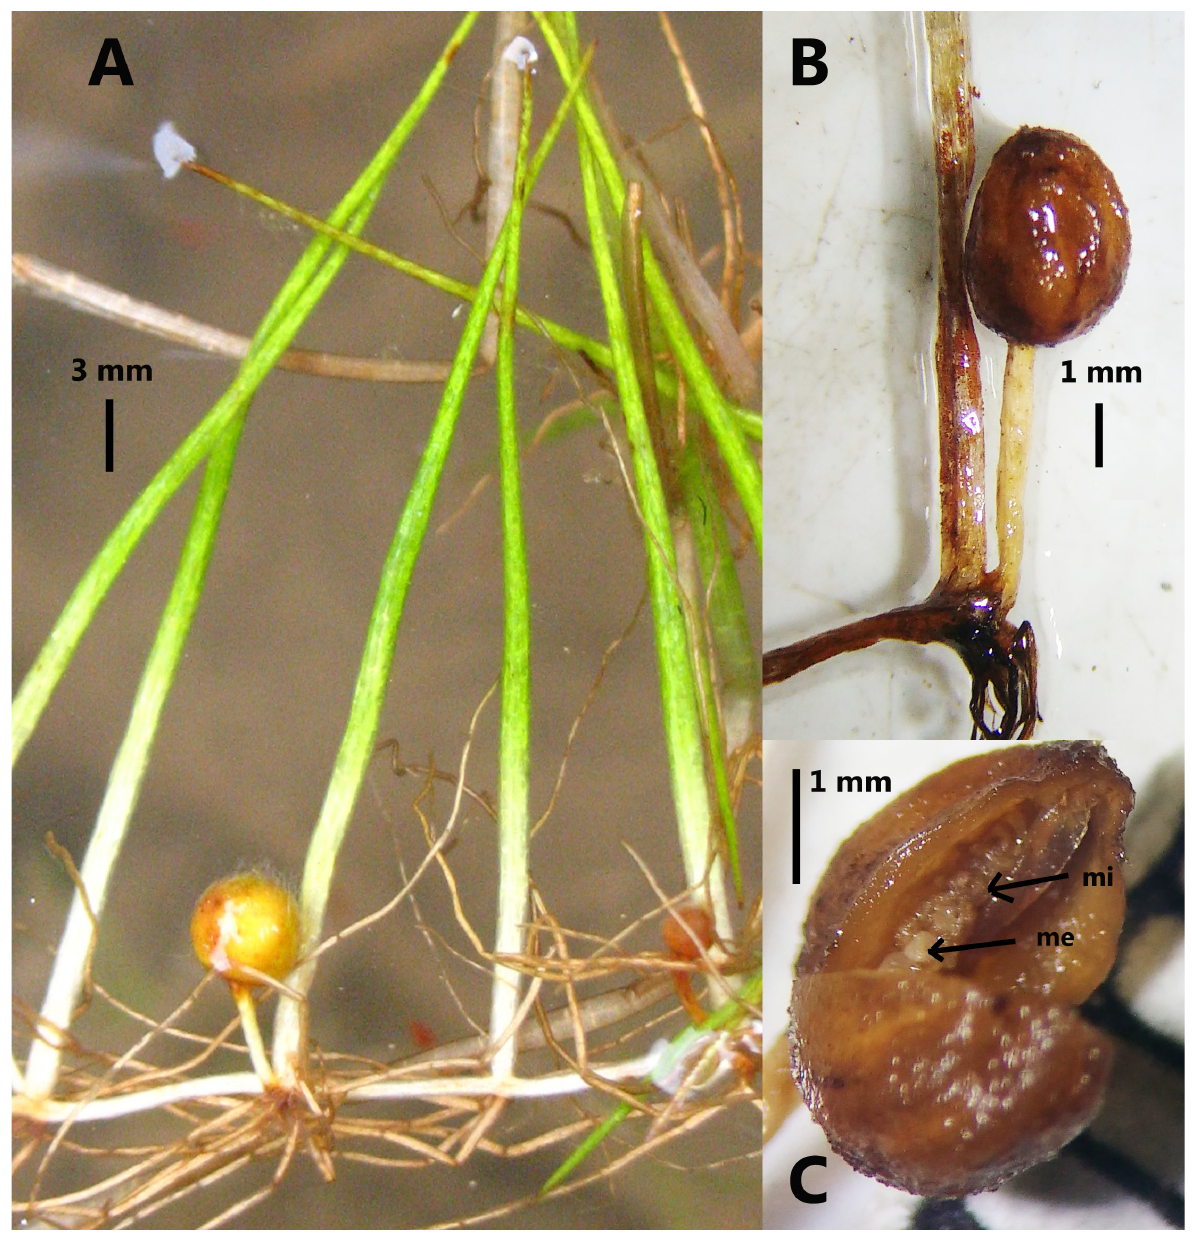
Figure 1. Pilularia Americana. A. Habit of plant collected in Ancash (M. Morales sn USM 300555). B. Sporocarp and pedicel. C. Longitudinal section of the sporocarp showing 2 locules. Arrows indicate a megasporangium (me) with a single megaspore, and a microsporangium (mi) with several